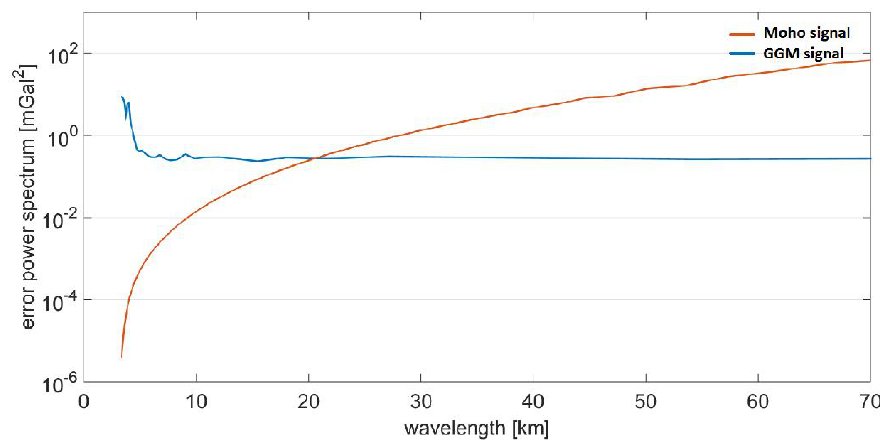
Figure 3. The Power spectrum of the Moho signal (red line) and GGM errors (blue